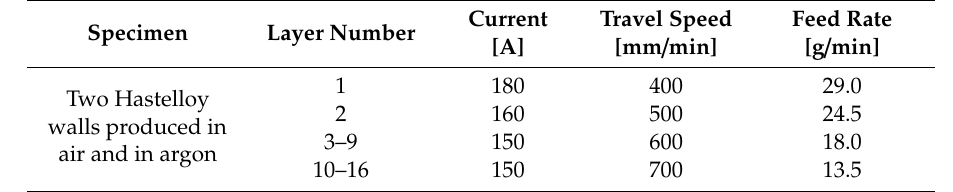
Figure 6. Walls in as-built conditions: ( a ) Produced under air atmosphere, ( b ) produced under argon atmosphere. Table 3. Fabrication parameters for Hastelloy C-22 wall produced in air and in argon atmosphere.